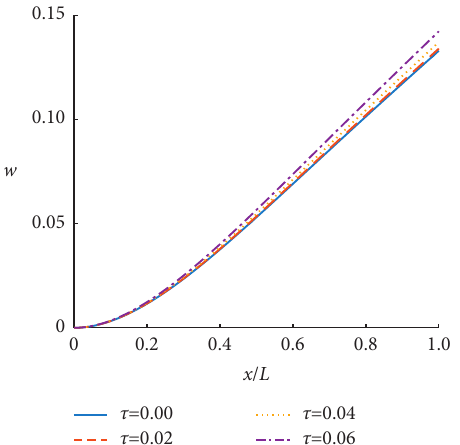
Figure 9: Influence of the nonlocal coefficient on the deflection amplification factor at different locations of the beam.